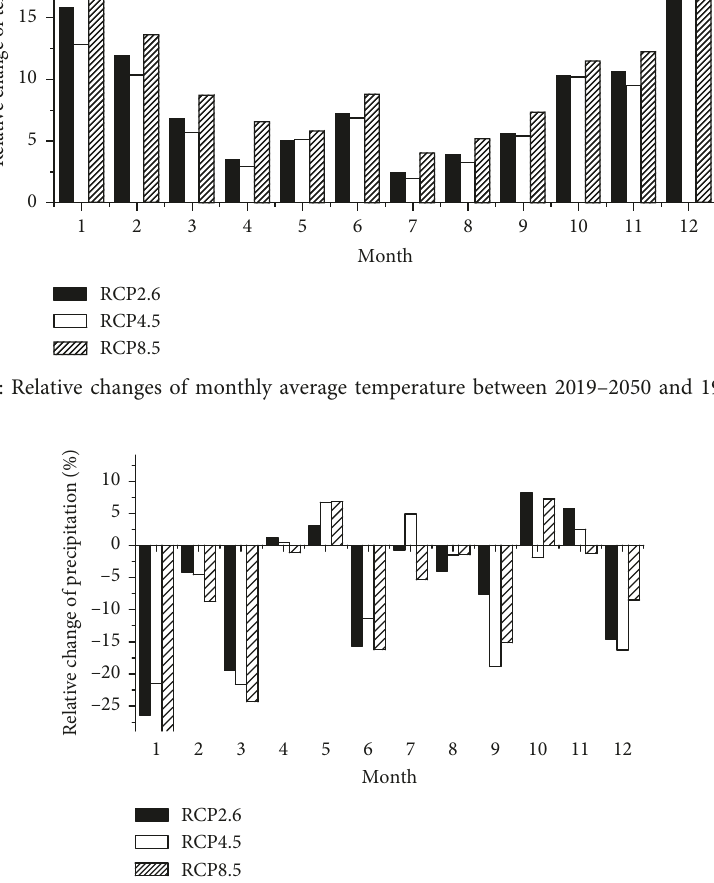
Figure 11: Relative change of monthly average precipitation between 2019–2050 and